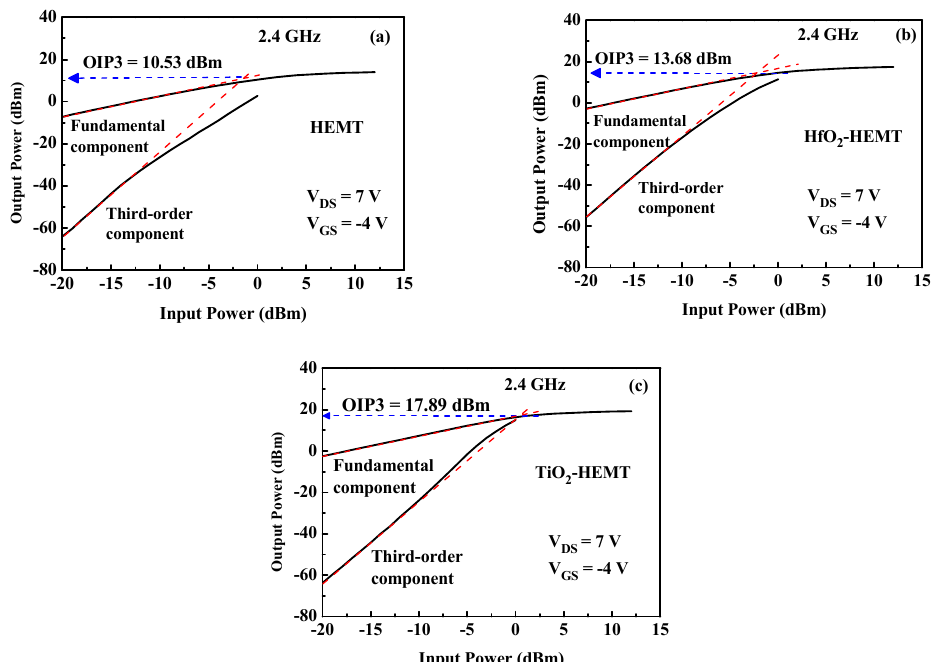
Figure 6. Fundamental output power and third-order intermodulation component of ( a ) HEMT, ( b ) HfO 2 -HEMT, and ( c ) TiO 2 -HEMT.